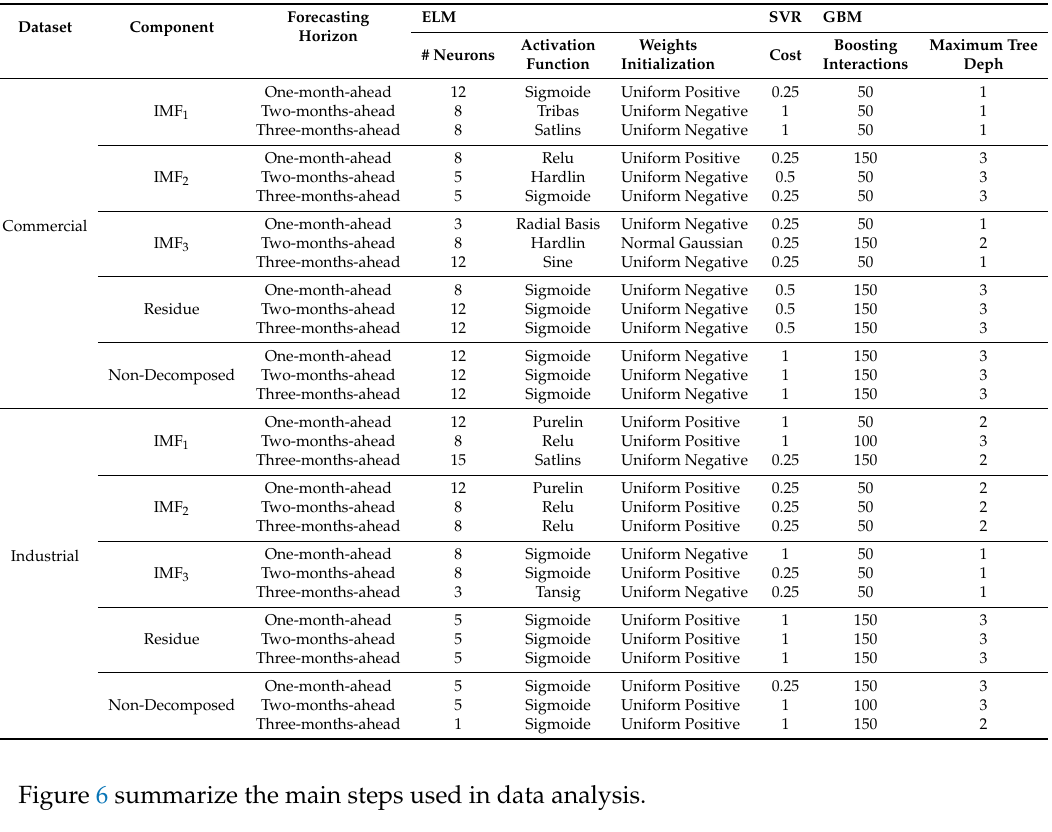
Table 4. Hyperparameters selected by grid-search for each adopted approach.